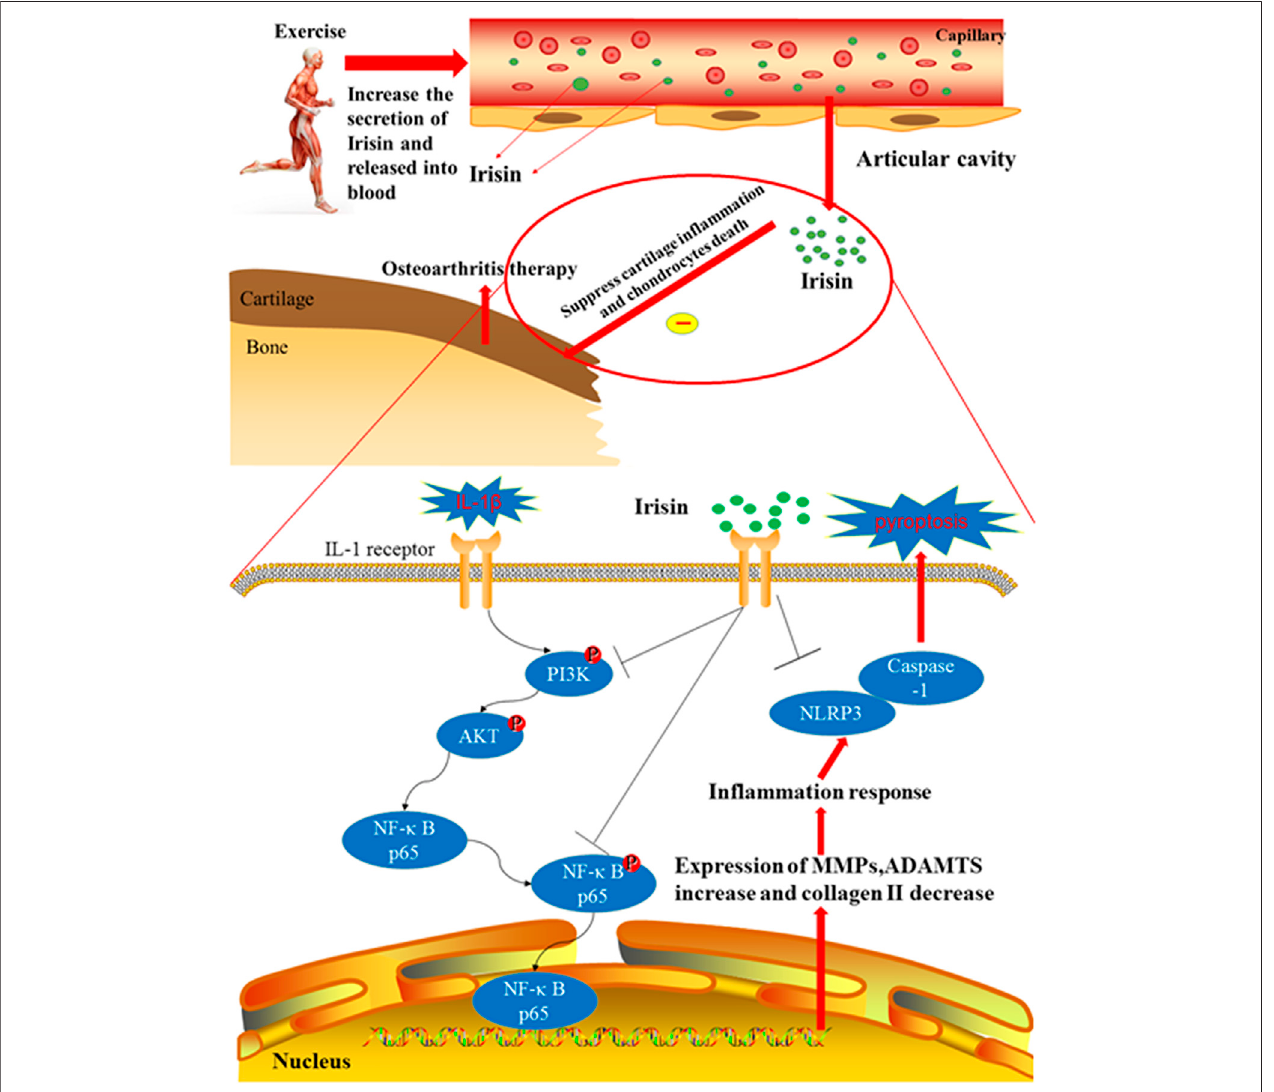
FIGURE7 | Therapeutic effectsofirisin on OAduring treadmill exercise via theinhibition ofthePI3K/Akt/NF- κ Bsignaling pathway and pyroptosis in chondrocytes. Irisin is secreted during appropriate treadmill exercise and then released into the blood, eventually reaching the knee articular cavity to play its role in inhibiting in fl ammation and pyroptosis. Exercise-induced irisin interaction with chondrocytes leads to the downregulation of in fl ammatory responses and suppression of cartilage matrix degradation, subsequently inhibiting pyroptosis in chondrocytes. In addition, irisin inhibits chondrocyte in fl ammation and in fl ammation-related pyroptosis in IL-1 β -induced OA chondrocytes by inhibiting the PI3K/Akt/NF- κ B signaling pathway.